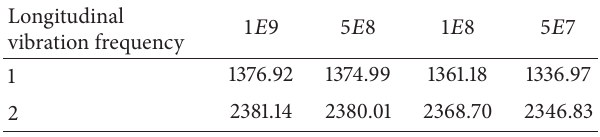
Table 8: The effect of the stiffness value of the isolator. Table 9: The frequency of the shafting with absorber